Question: How would you classify this visualization?
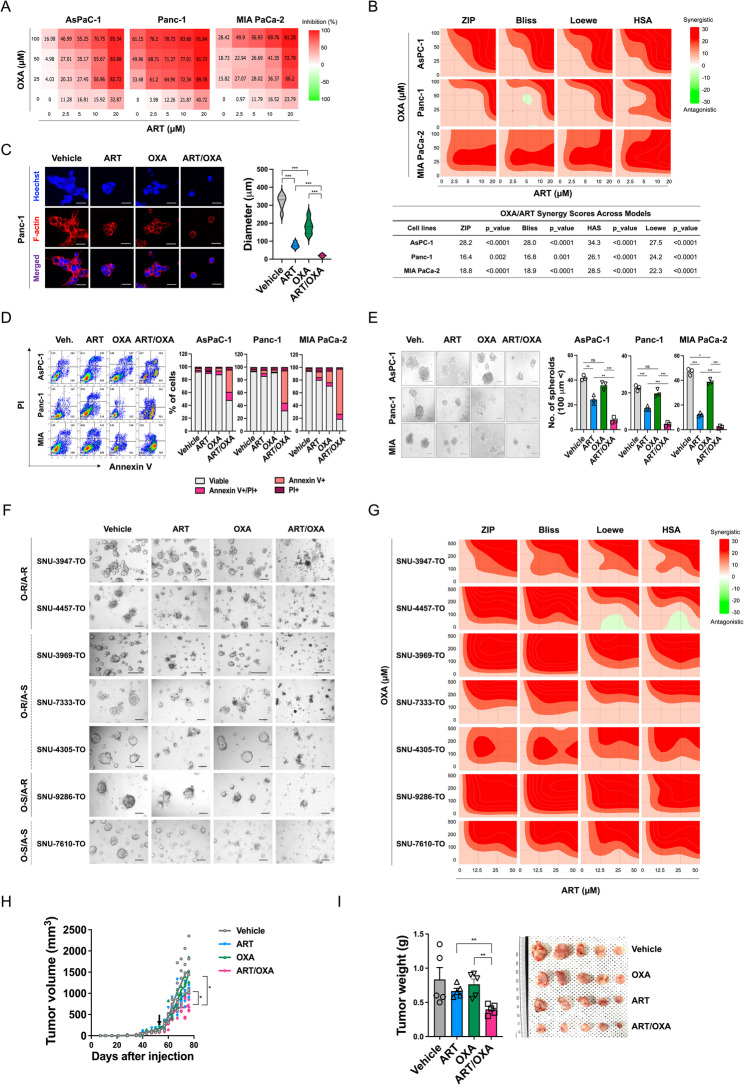
Answer: line